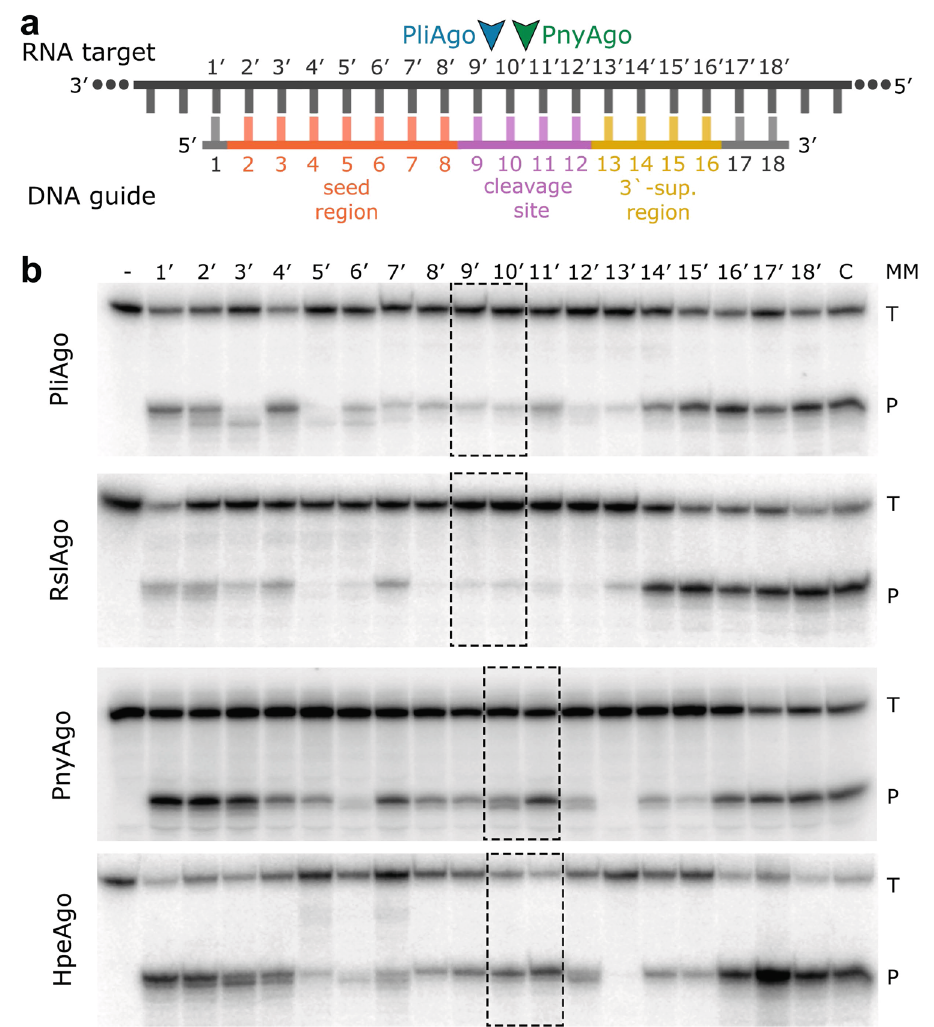
Fig. 6 | D-R pAgos sense mismatches in the RNA target. a Scheme of the guide- targetduplexwithindicatedfunctionalregionsinguideDNA.Thecleavagesitesby PliAgoand PnyAgo are indicated. b Effects of single-nucleotide mismatchesonthe ef fi ciencyofRNAcleavagebyD-RpAgos(seeSupplementaryTable1forguideDNA andtargetRNAsequences).Thereactionswereperformedwith5 ’ -P 32 -labeledtarget